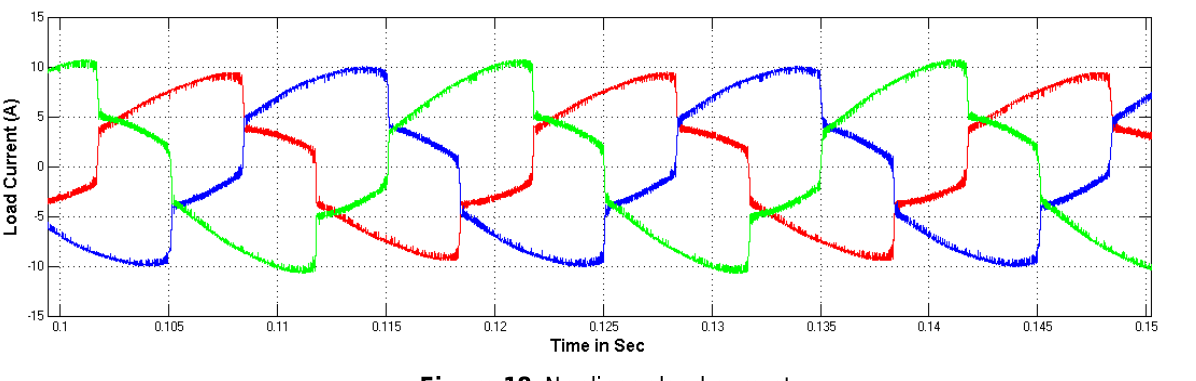
Figure 18. Nonlinear load current